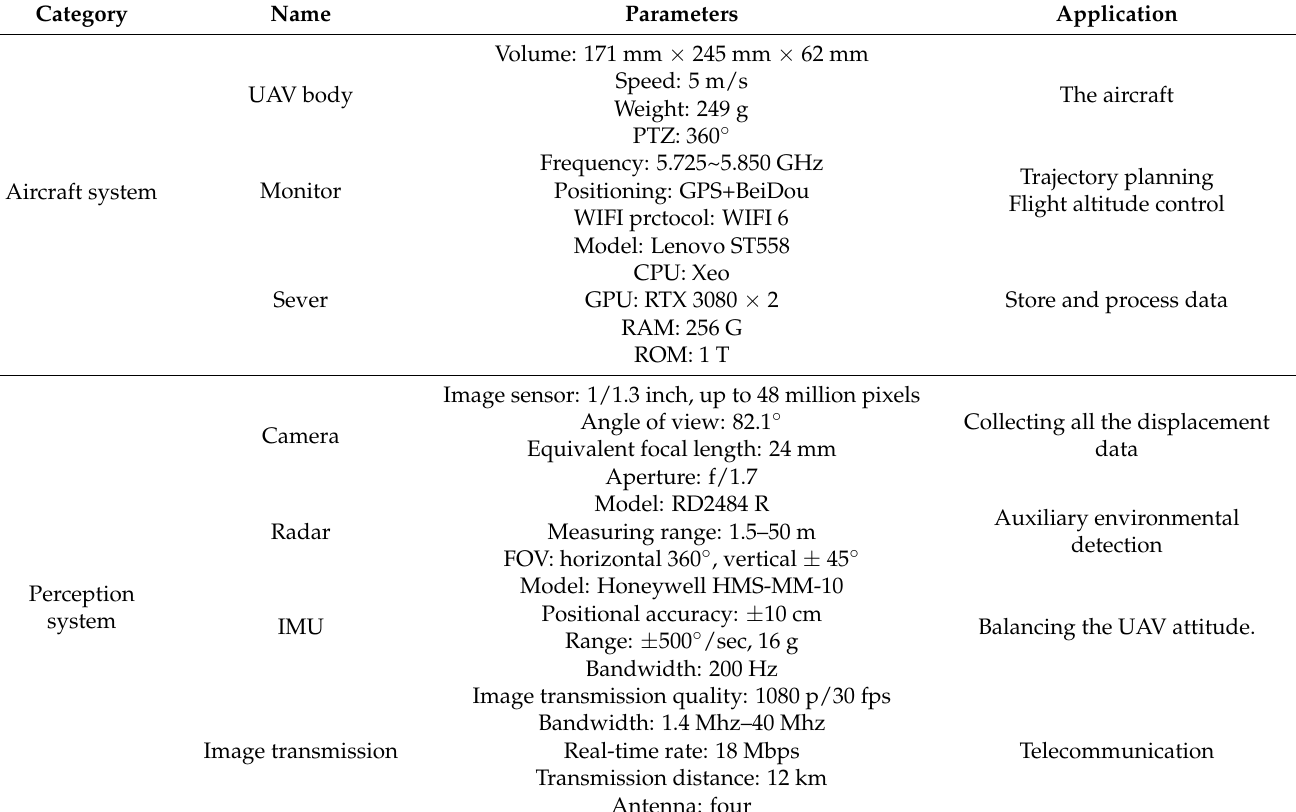
Table 5. The UAV system